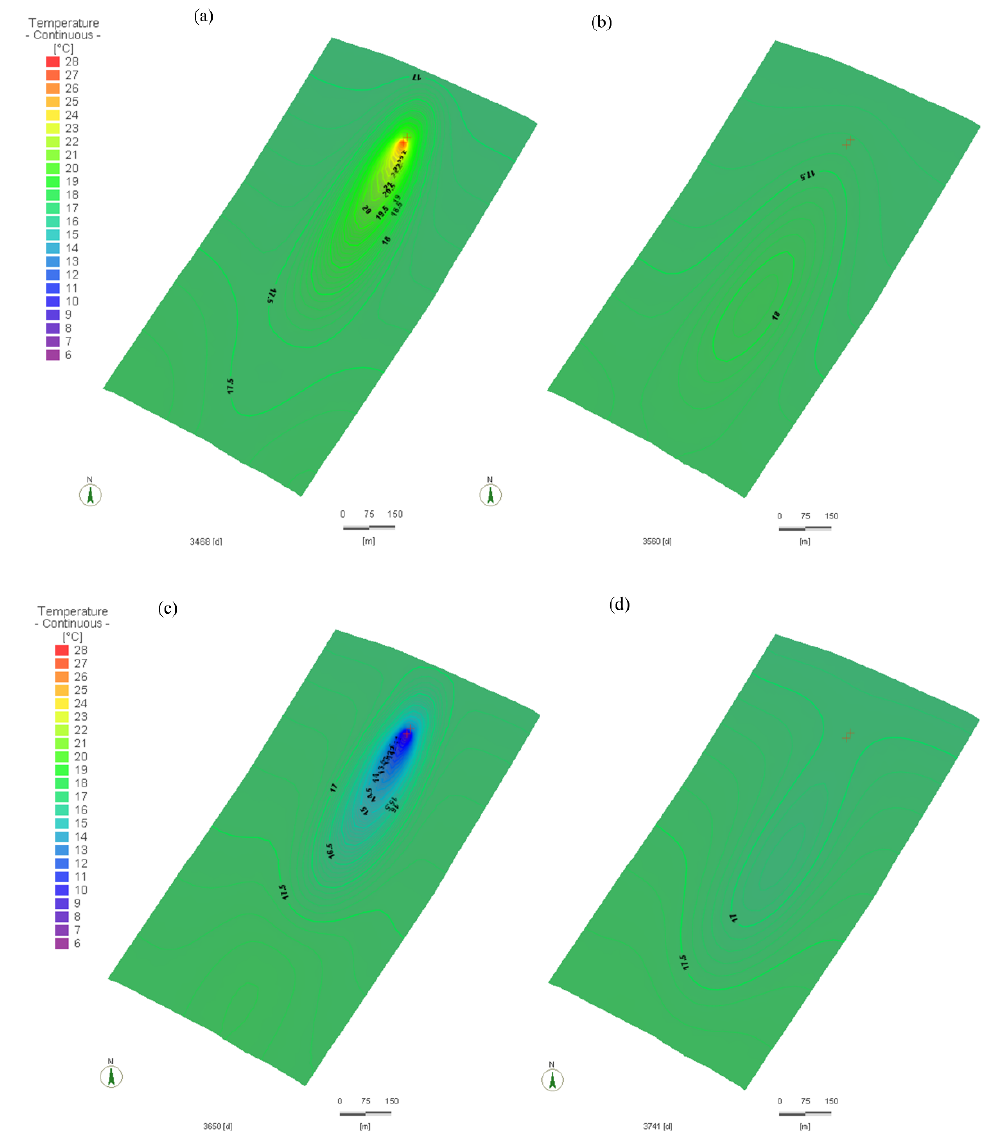
Figure 15. Thermal changes on variation VI (3.33 × 10 − 2 m 3 /s, 10 ◦ C) pumping rate 3.33 × 10 − 2 m 3 /s and injection temperature 10 ◦ C on local model 2, ( a ) during cooling operation, ( b ) after 90 days of cooling operation, ( c ) during heating operation, and ( d ) after 90 days of heating operation.